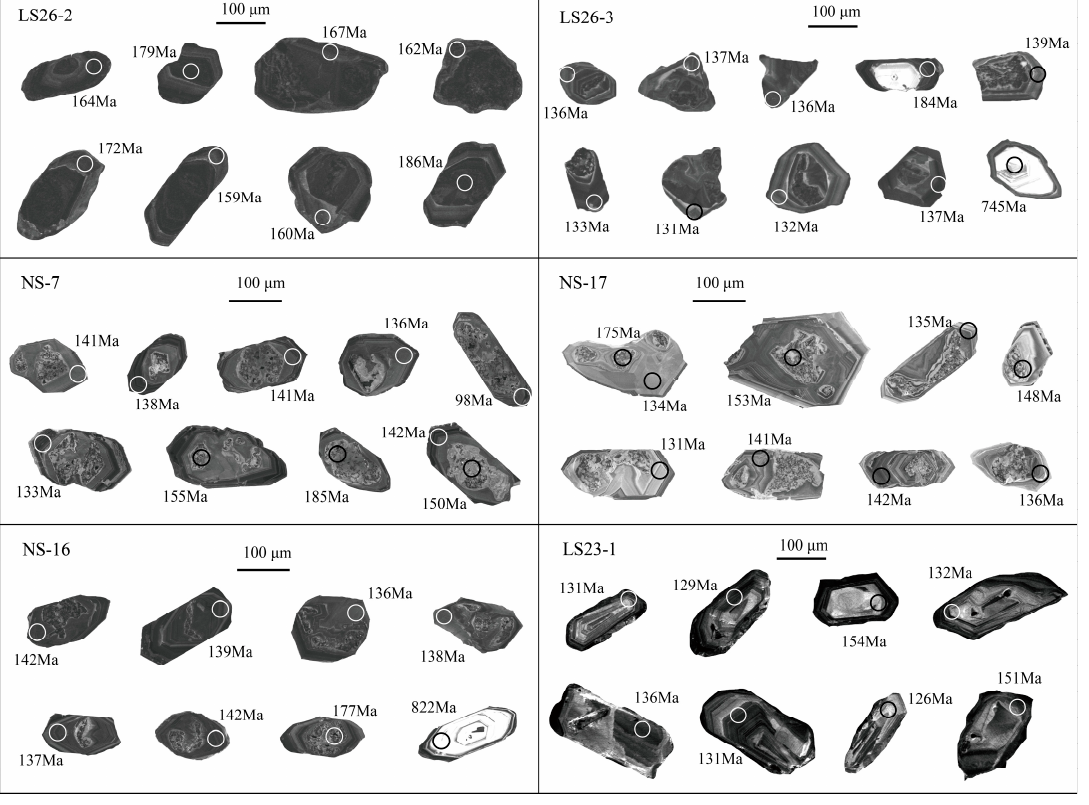
Figure 9. Representative cathodoluminescence (CL) images of zircon grains for the rocks from the Lushan area. Circles indicate analyzed spots of U-Pb dating and zircon U-Pb ages are also shown.